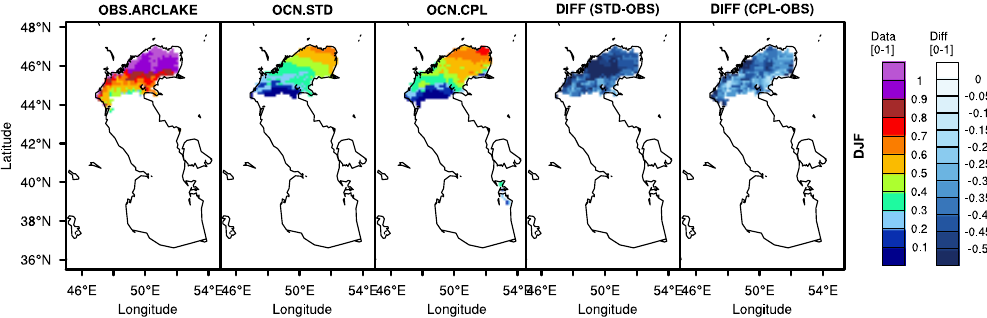
Fig. 17. DJF season climatology of lake ice coverage for the period 1999–2008 in ARCLAKE observation (fraction), OCN.STD and OCN.LAK (fraction) simulations. Values lower than 0.01 are masked out.